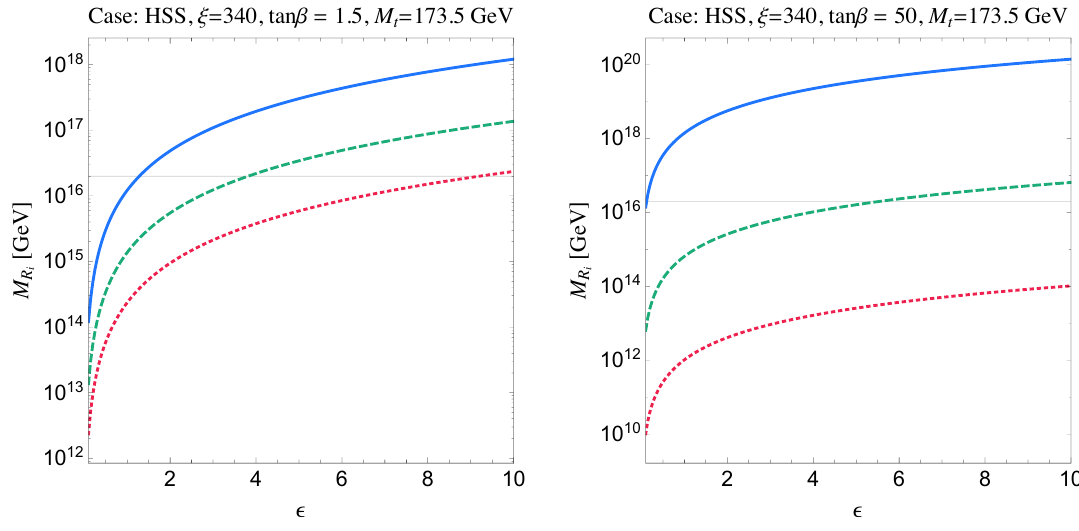
Figure 2 . The mass spectrum of RH neutrinos with respect to the (cid:15) parameter, as obtained from the condition in eq. (2.9) with (cid:24) = 340 and N = 2 : 07 and seesaw formula eq. (2.7) and eq. (4.1) for tan (cid:12) = 1 : 5 (left panel) and tan (cid:12) = 50 (right panel). The horizontal line corresponds to the value M S = 2 (cid:2) 10 16